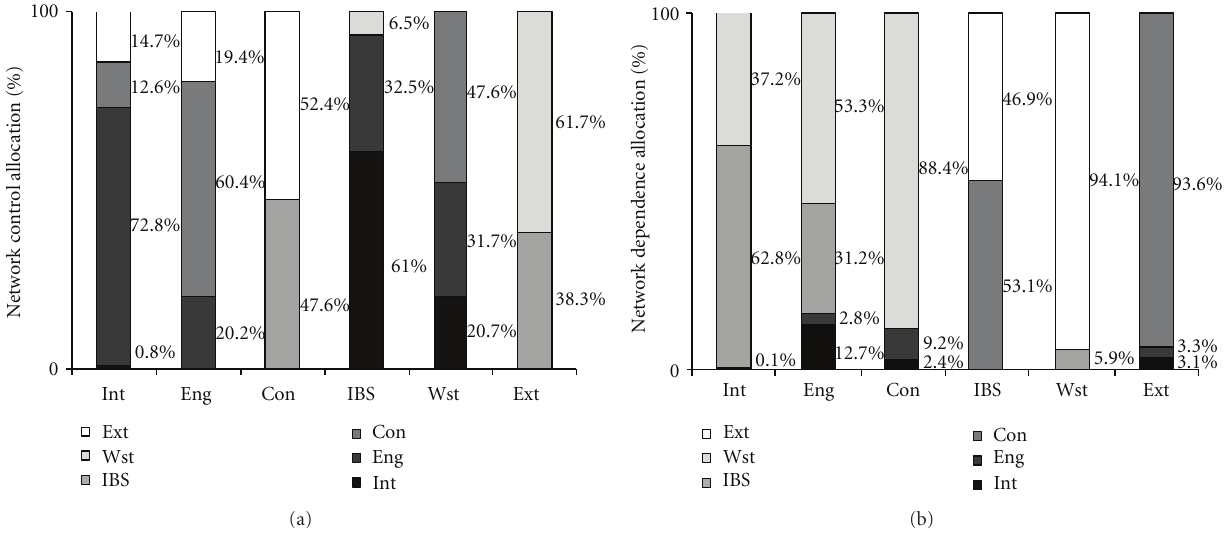
Figure 3: (a) Network control of carbon metabolism in BDA. (b) Network dependence of carbon metabolism in BDA. Because the value of total supplied carbon from Grn is zero, we did not consider the influence from Grn in these figures for an easy calculation.